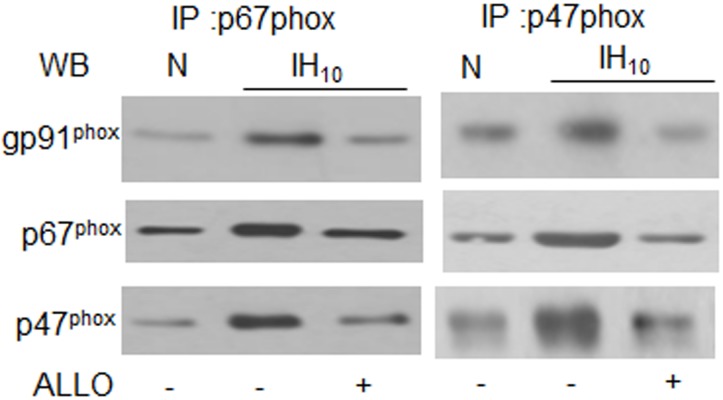
Nox2 complex formation by IH requires XO.Nox2 complex immunoprecipitated from membrane fraction of cells exposed to normoxia (N) or IH10 with p67phox or p47phox antibody and analyzed for gp91phox, p67phox and p47phox proteins by immunoblot.